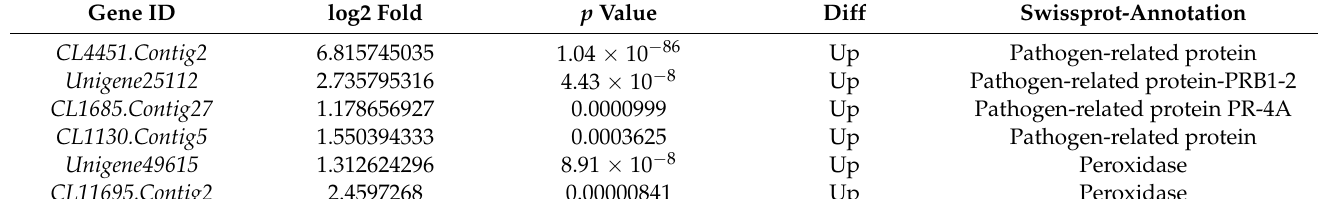
Table 1. Genes related to pathogen-related protein.